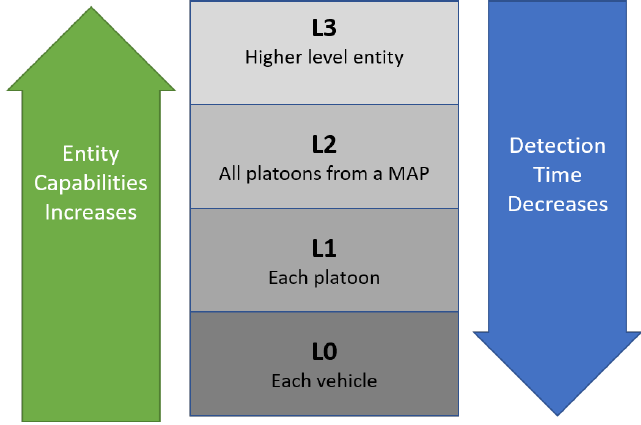
Figure 9. Cluster level needs vs.